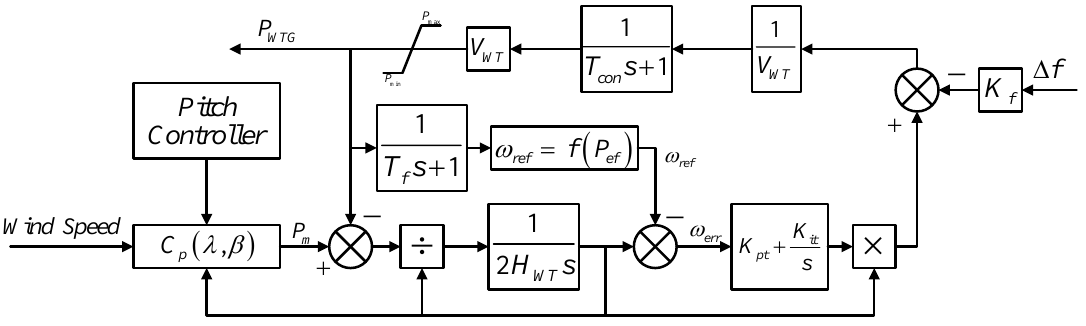
Figure 2. Variable-speed wind turbine generator model. Table 2. Wind turbine generator (WTG) model parameters used for